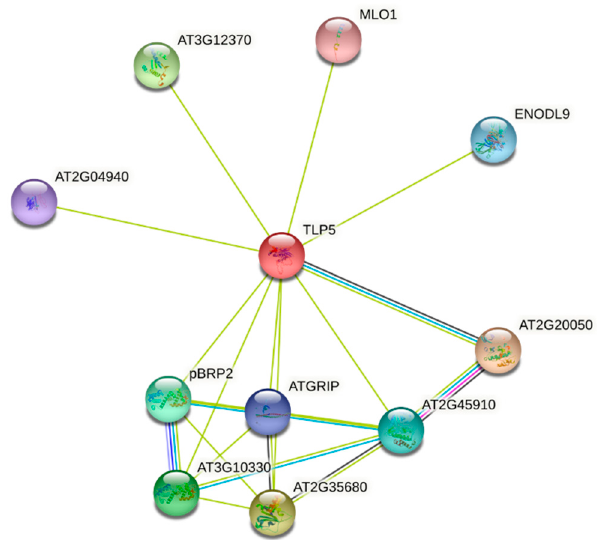
Figure 3. TaTLP gene GO enrichment analysis shows molecular function, biological process, and cellular component data.